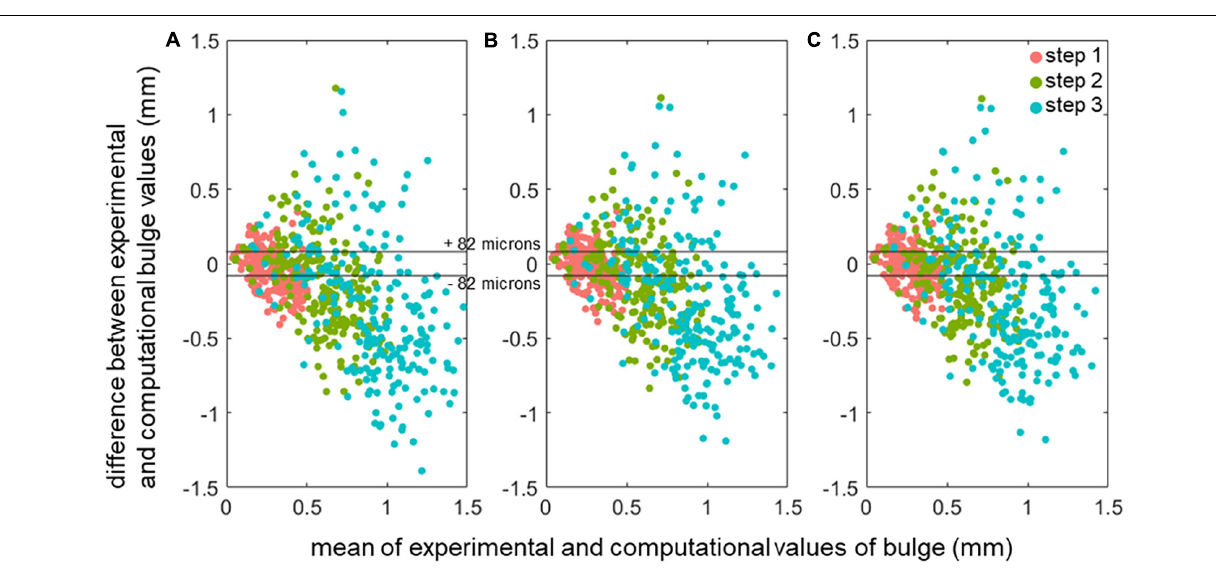
FIGURE 8 | Comparison of the in silico predicted displacements of the disc marker points versus the measured in vitro values, shown as mean-difference plots for the three different model types with the 1-to-1 calibration. (A) std. cyl. models (B) fit. cyl. models (C) MR models. The image resolution band is shown with horizontal